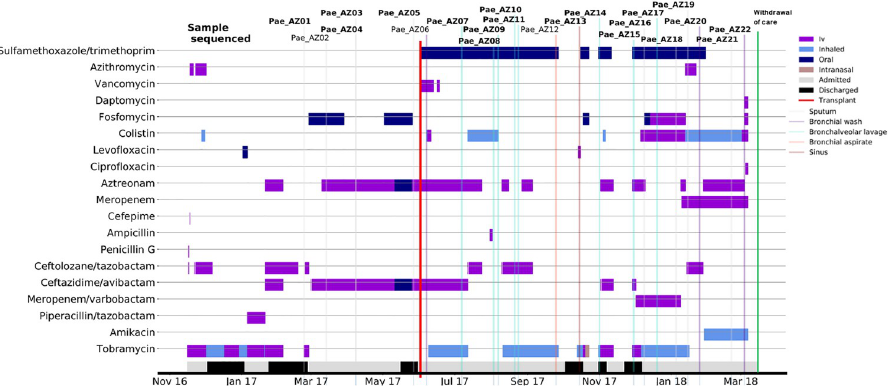
Fig 1. Timeline of antibiotic treatment and isolates recovered from the CF patient within the 17-month period until the withdrawal of care. Indicated in bold are isolates that underwent whole genome